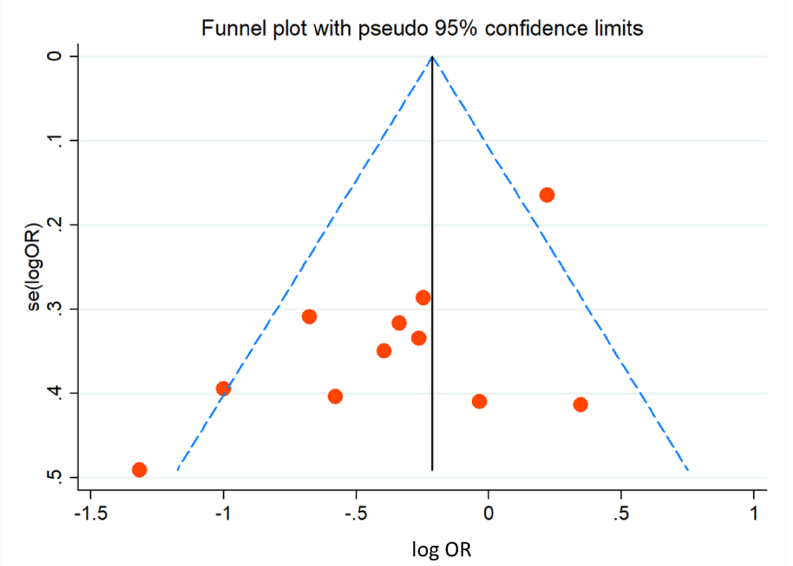
Figure 5: The Begg’s funnel plot s indicated no significant publication bias in evaluation of MTHFR C677T polymorphism and non-traumatic osteonecrosis of the femoral head(CC vs